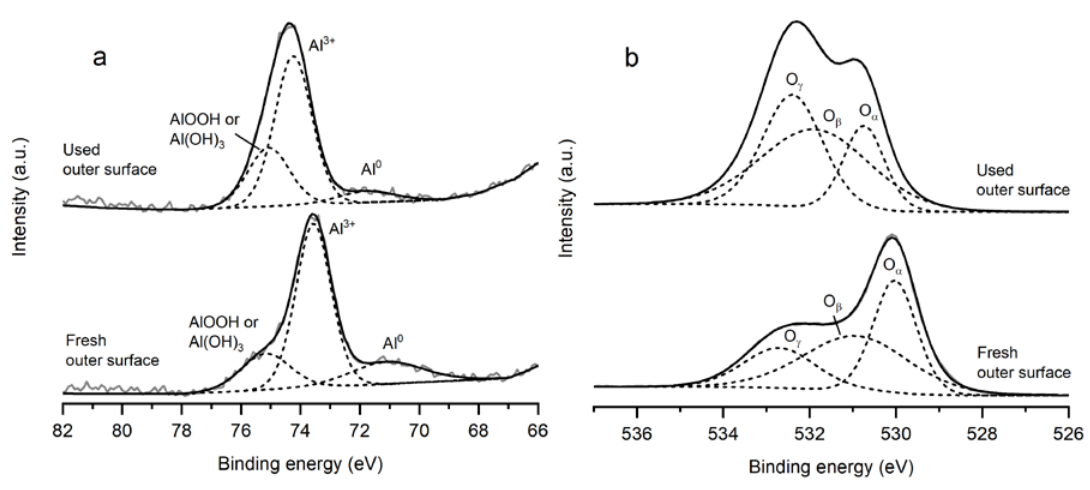
Figure 13. The XPS spectra of Al 2p ( a ) and O 1s ( b ) for fresh and 16 h CoAlCe-P.